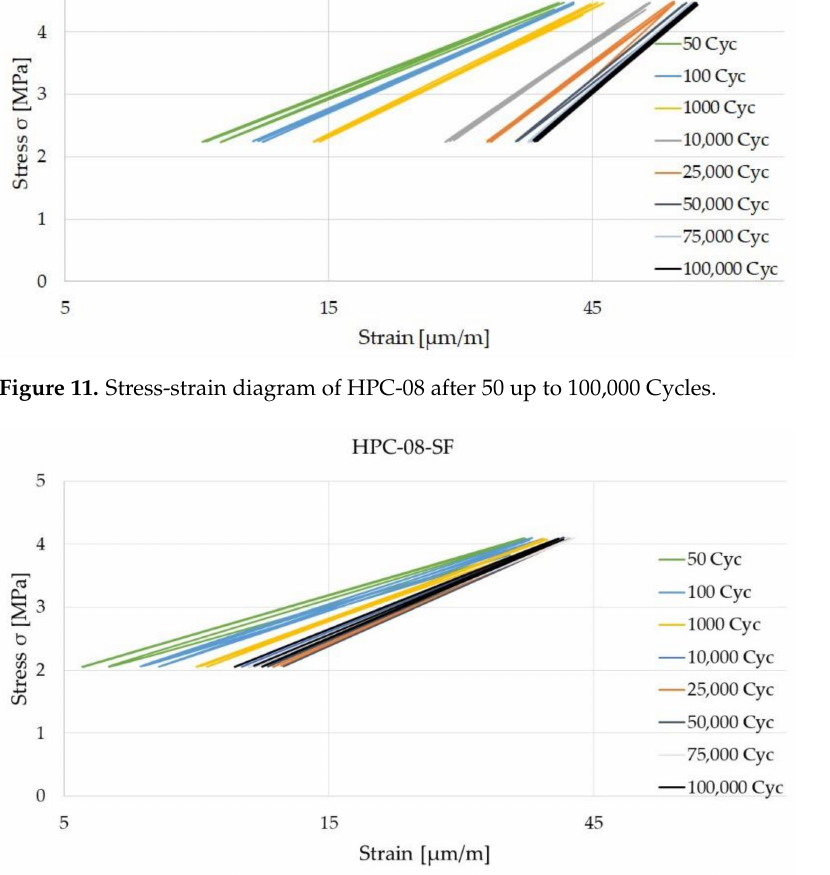
Figure 12. Stress-strain diagram of HPC-08-SF after 50 up to 100,000 Cycles.